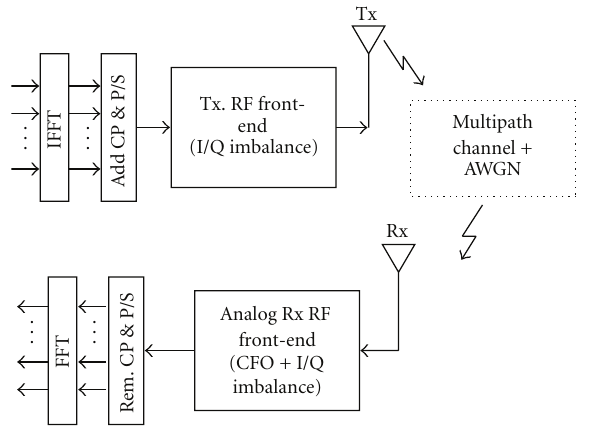
Figure 2: OFDM system model with I/Q imbalance and